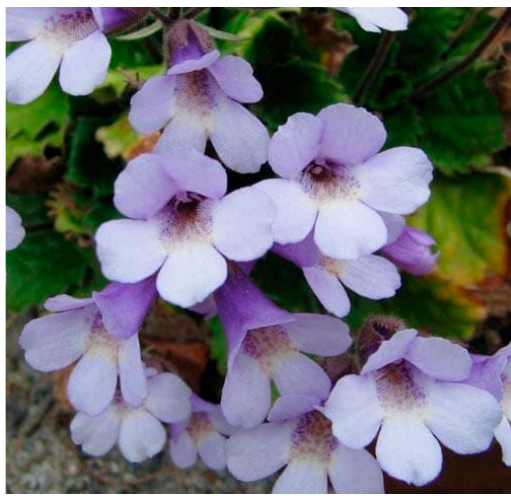
Figure 3. Flowers of Haberlea rhodopensis.